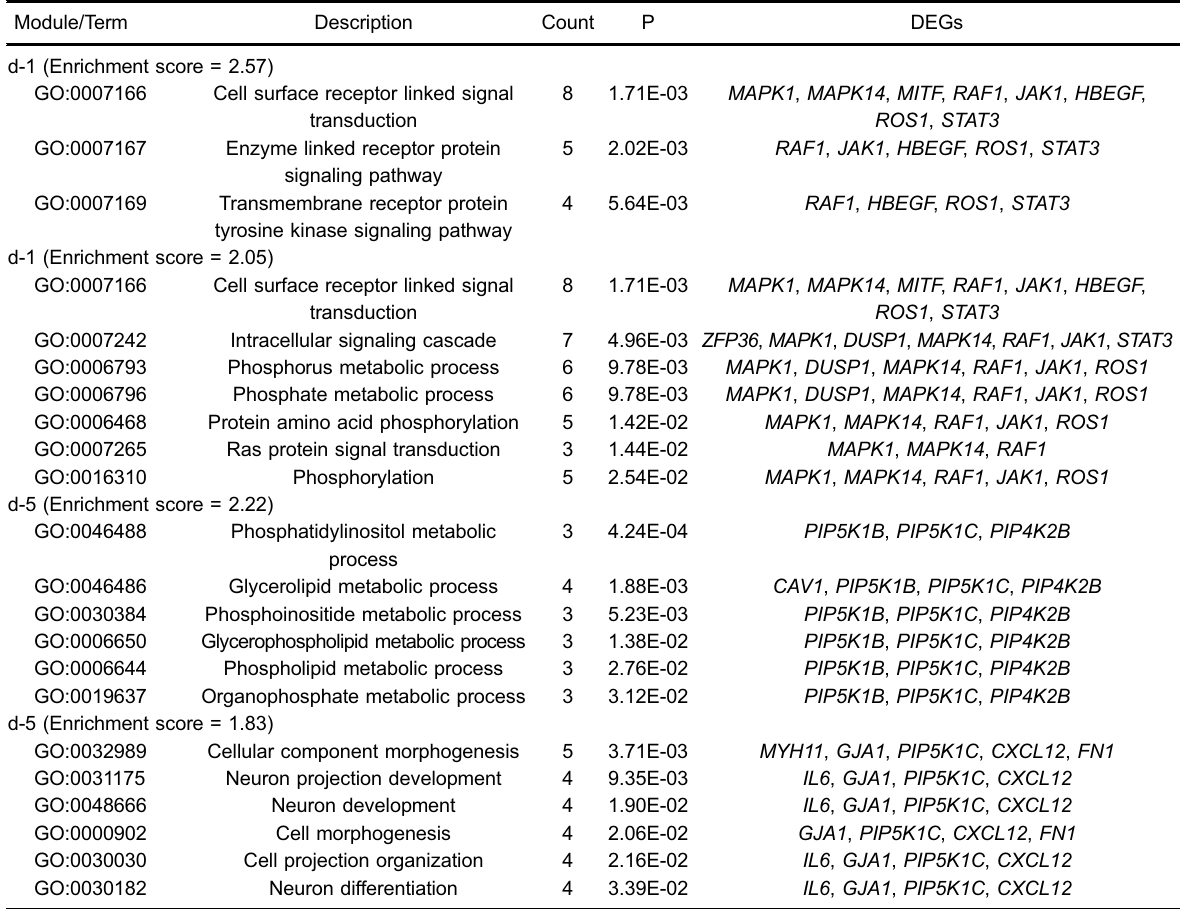
Table 4. Enriched functions for genes in downregulated modules with a higher enrichment score.